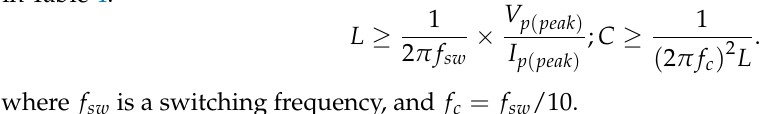
Table 4. Parameters of a Multi-VSG Microgrid.